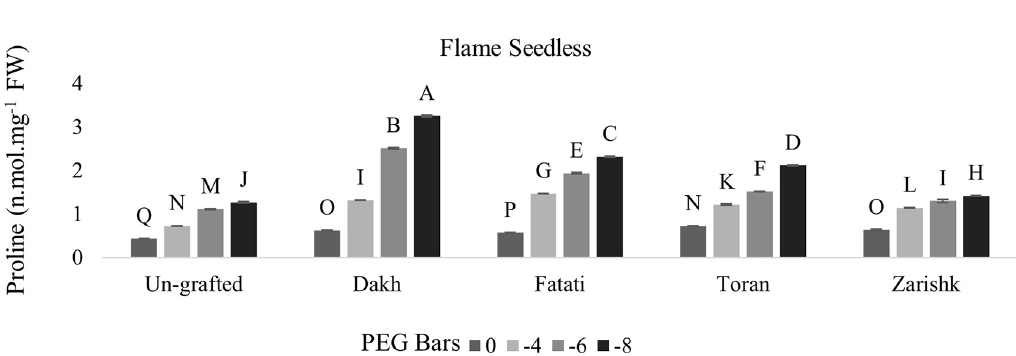
Fig 6. Proline content of un-grafted and grafted Flame Seedless scion variety on different wild grapevines under drought stress condition. Data is represented as mean SD and letters showed significant difference at p < 0.05.